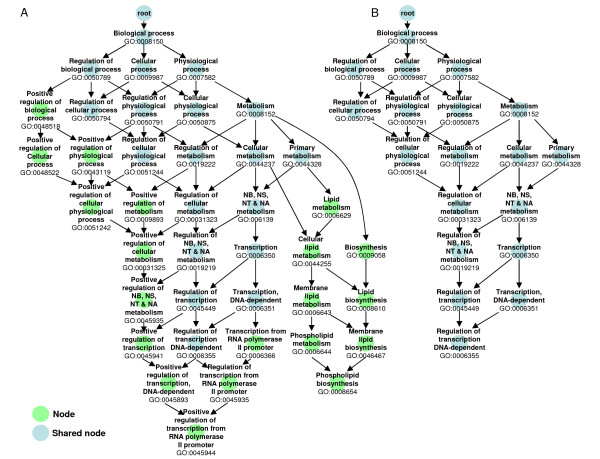
Graph similarity scoring method. The induced GO graphs for two yeast proteins illustrate graph similarity scoring using the Bioconductor method simUI. (A) The GO terms GO:0045944 positive regulation of transcription from RNA polymerase II promoter and GO:0008654 phospholipid biosynthesis are assigned to INO4/YOL108C. (B) The GO term GO:0006355 regulation of transcription, DNA-dependent is assigned to RSC30/YHR056C. The graph similarity between these two proteins is calculated by dividing the number of terms that are found in both of the individual induced GO graphs for each protein (shared nodes in blue) by the number of unique terms in both graphs. The graph similarity equals 20 shared nodes/40 unique nodes = 0.5